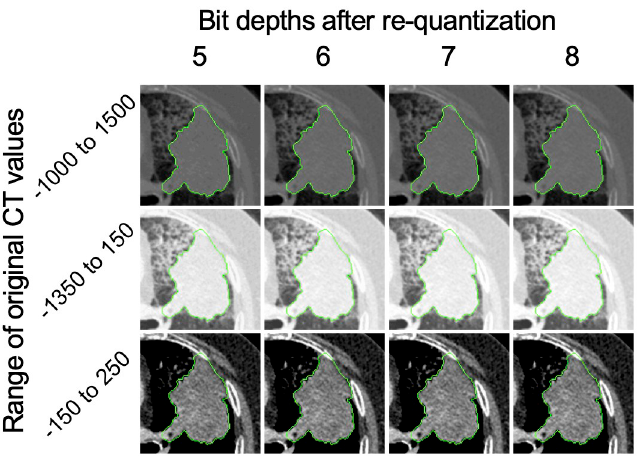
Fig 3. q -bit images generated from the computed tomography (CT) images using four ranges of Hounsfield units (HU) of CT images (-1000 to 1500 HU, -1350 to 150 HU [lung range window], and -150 to 250 HU [mediastinal range window]) with four bit-depths after re-quantization (5, 6, 7, and 8 bits).